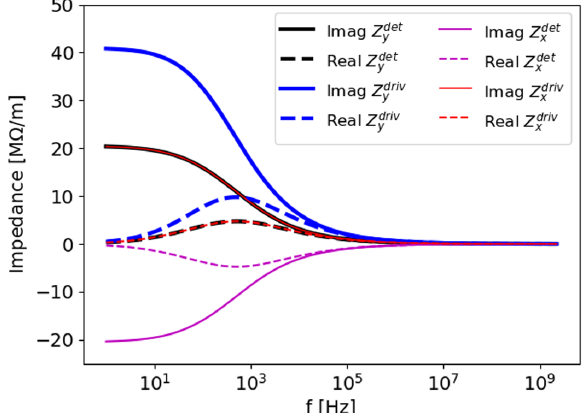
FIG. 1. Vertical driving and detuning impedances (respectively in blue and black), and horizontal driving and detuning imped- ances (in red and magenta) for a flat pipe made of two parallel plates of stainless steel (electrical resistivity of 7 . 2 × 10 − 7 Ω m,